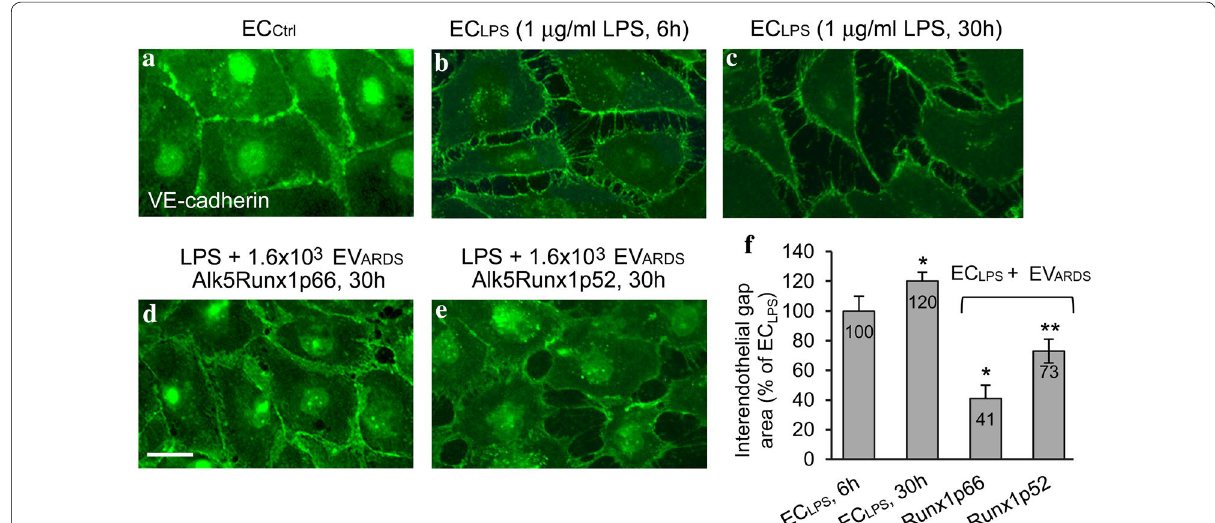
Fig. 6 EV ARDS Alk5Runx1p66 improve the interendothelial junctional integrity of LPS-treated ECs. Representative VE-cadherin/Alexa Fluor 488 staining of EC Ctrl ( a ), ECs treated with 1 μg/ml LPS (EC LPS ) for 6 h ( b ) and 30 h ( c ); EC LPS (6 h) were treated for 30 h with either ( d ) 1.6 EV ARDS Runx1p66/1 ml growth media or ( e ) 1.6 10 3 EV ARDS Runx1p52/1 ml growth media (non-surviving ARDS patient). Bars: 15 μm ( a – e ). f × Morphometric analysis of the interendothelial gap area. All data labels are included for each bar.